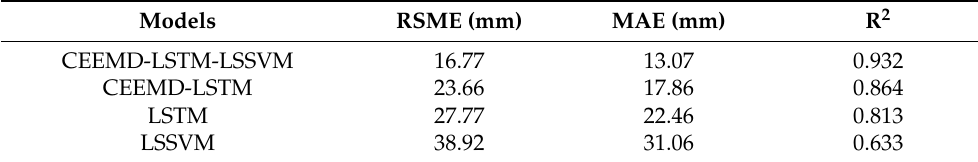
Table 5. Prediction accuracy of different